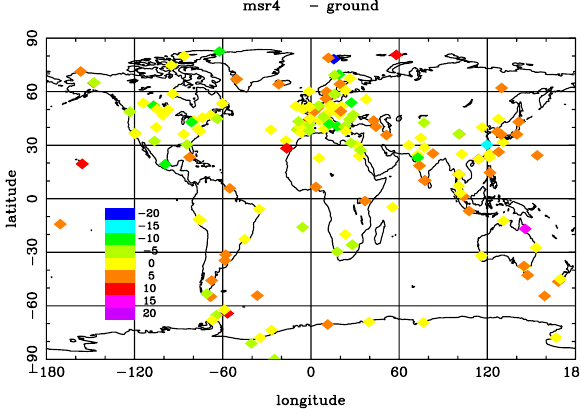
Fig. 6. Fitted offset (MSR-ground) between the MSR level 4 data and all selected ground measurement in the period 1978–2008.